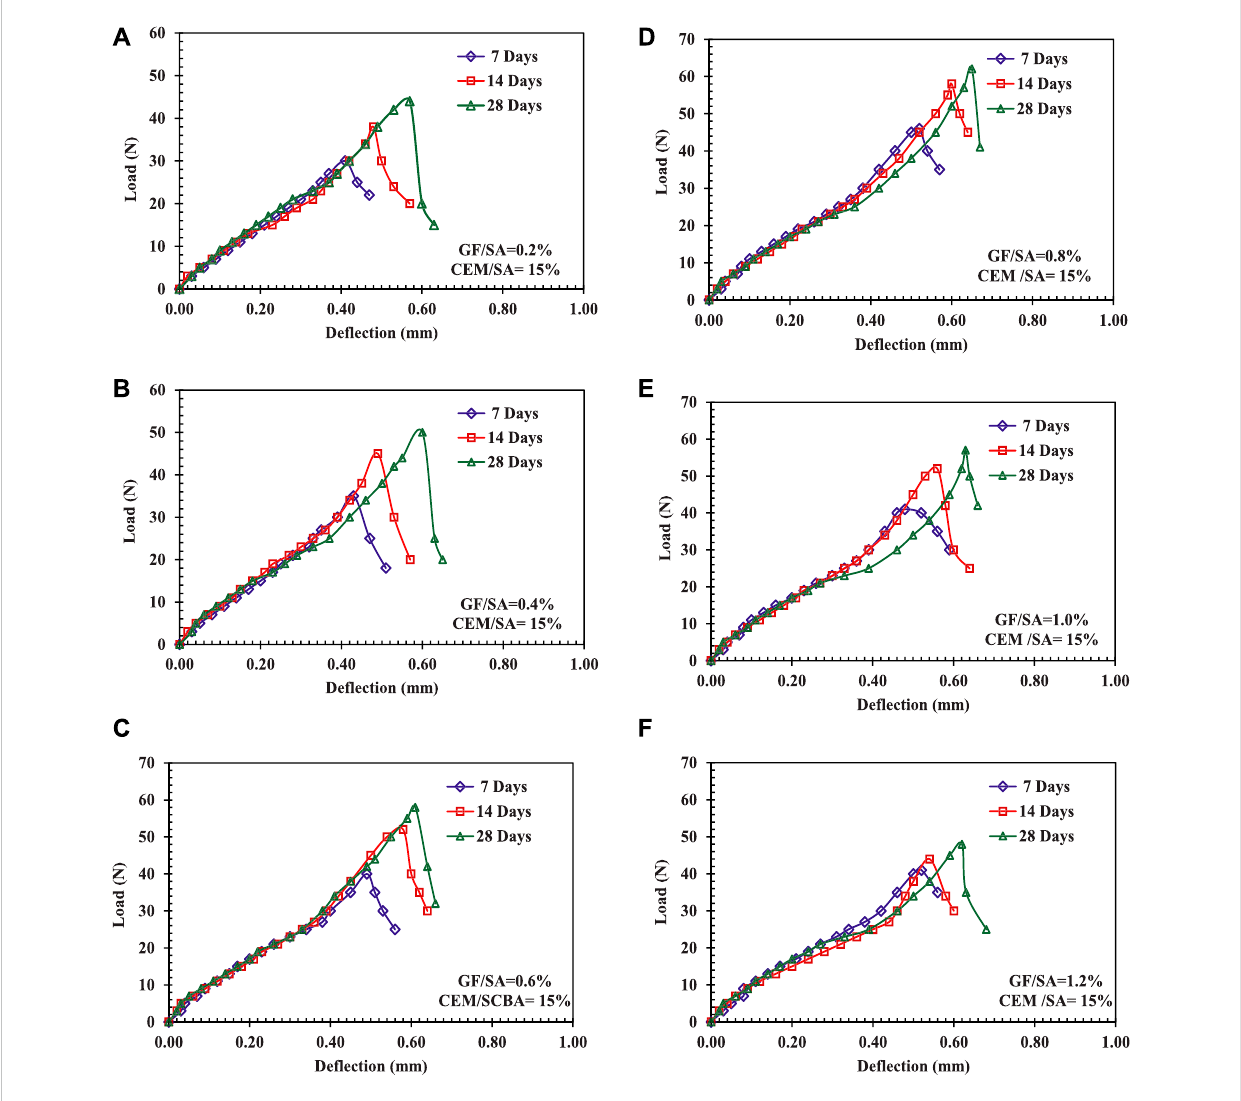
FIGURE 12 Load vs. de fl ection curve of prepared materials for all curing periods at GF/SA mix ratios of (A) 0.2%; (B) 0.4%; (C) 0.6%; (D) 0.8%; (E) 1.0%; (F) 1.2%, and CEM/SA ratio of 15%.